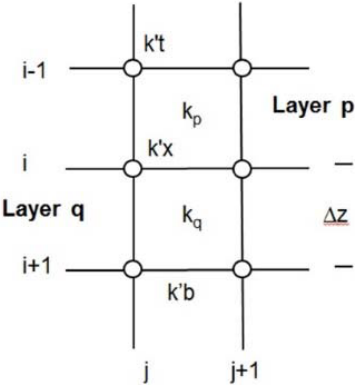
Figure 1. Finite difference scheme.